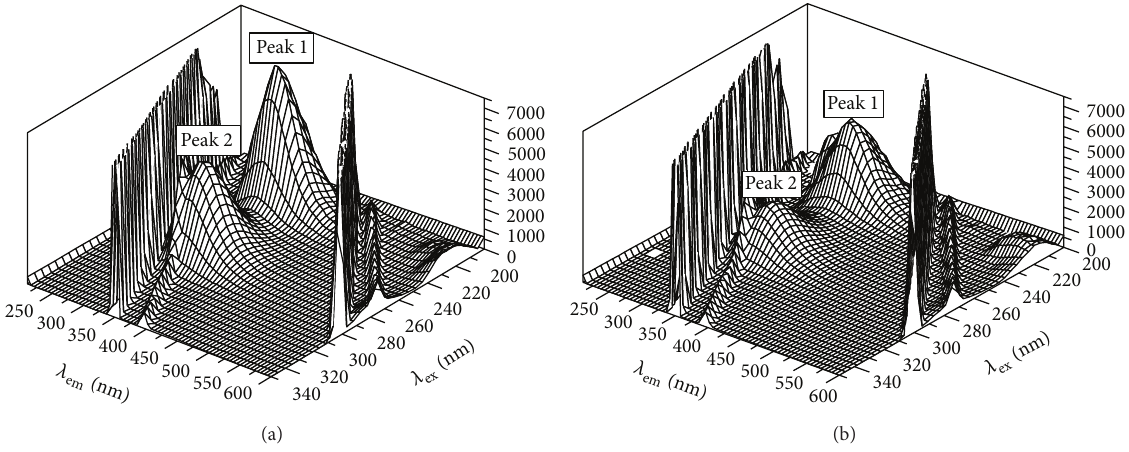
Figure 8: Three-dimensional spectra of BSA (50 𝜇 g ⋅ mL −1 ) in the absence (a) and presence (b) of EVG (10 𝜇 g ⋅ mL −1 ).